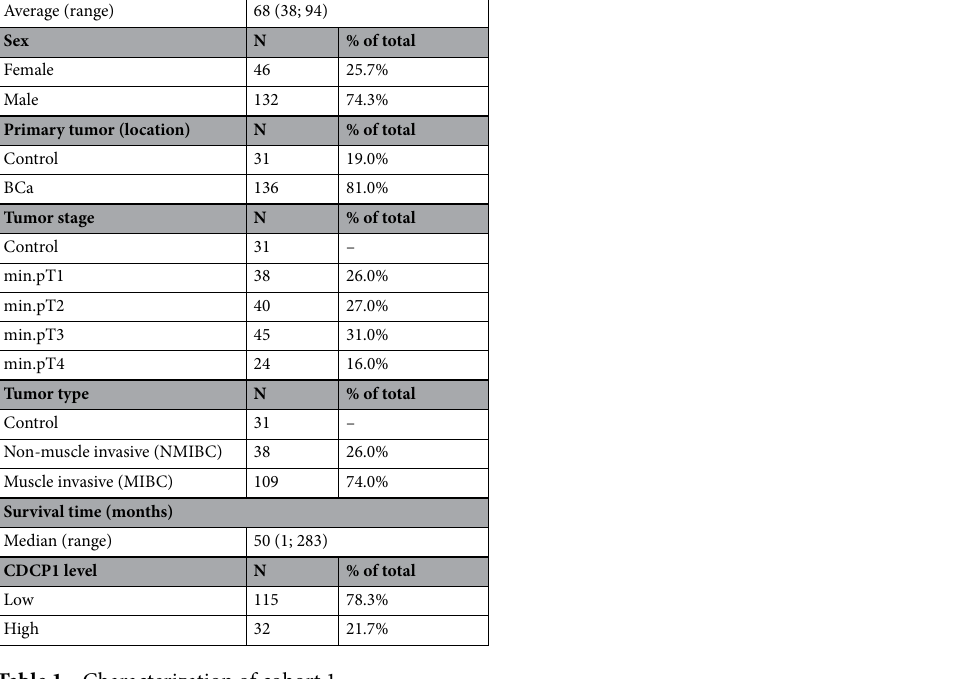
Table 1. Characterization of cohort